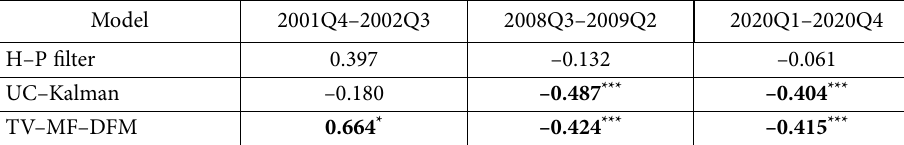
Table 3. Estimation results of the counterfactual T test